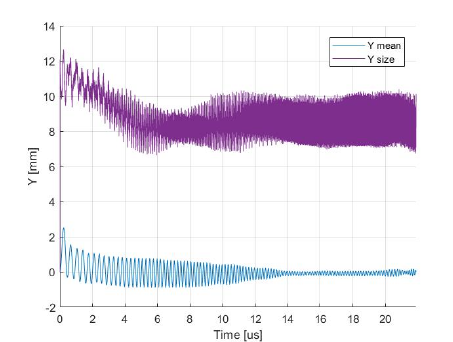
Figure 19. Beam transverse envelope for the standard operation